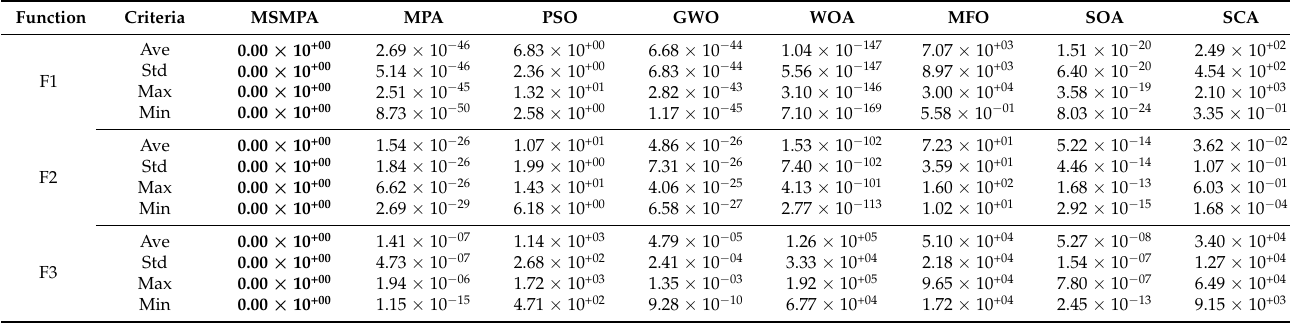
Figure A2. Box line diagram of partially selected functions. Table A1. Test results of 18 benchmark